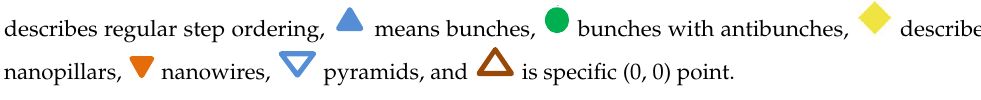
Figure 6. Diagram of pattern formation. Different symbols correspond to different patterns: de- scribes regular step ordering, means bunches, bunches with antibunches, describe nano- pillars, nanowires, pyramids, and is specific (0, 0) point.